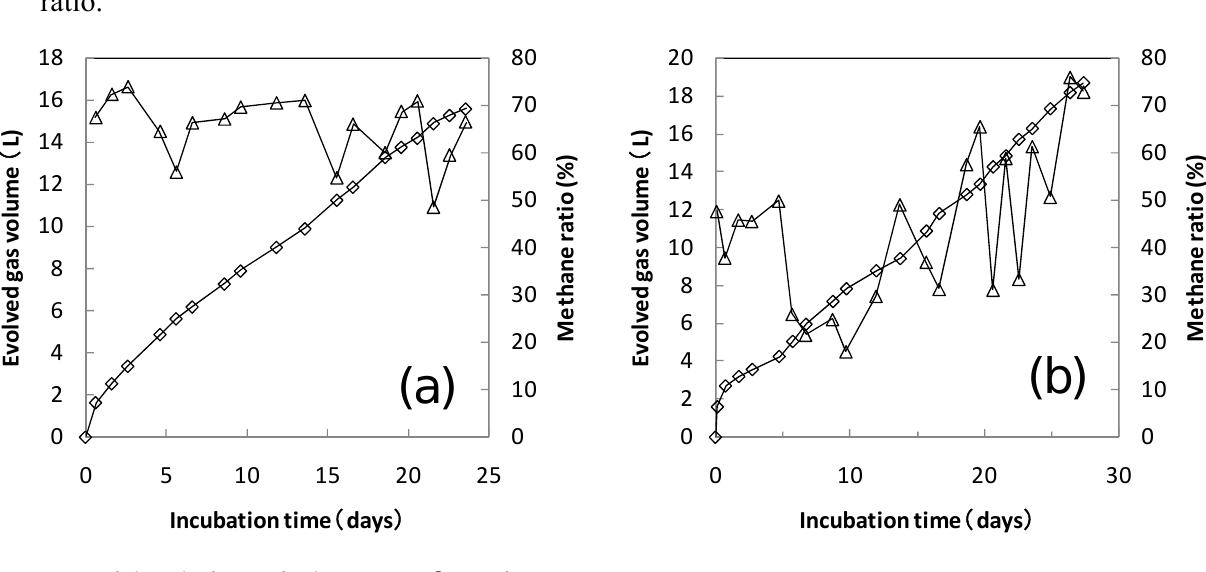
Figure 4. Evolved gas volume and methane ratio during preincubation of the sludges. The sludges were incubated at 35  C (a) and 55  C (b). ◊ ; Evolved gas volume, ∆ ; methane